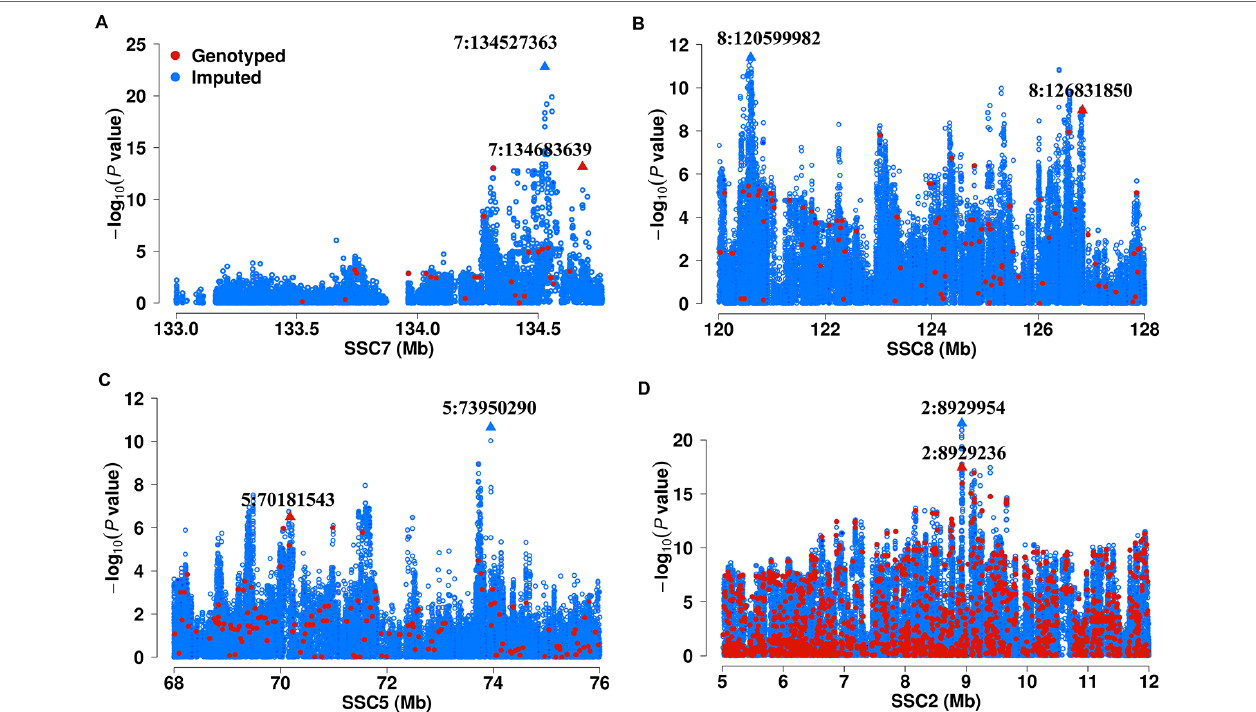
FIGURe 1 | Comparison of association strength between imputed and chip SNPs. (A) region for C20:1n-9 on SSC7 in F 2 population; (B) region for C18:1n-9/ C16:1n-7 on SSC8 in F 2 population. (C) region for C20:0/C18:0 on SSC5 in Sutai population. (D) region for C20:3n-6/C18:2n-6 on SSC2 in Erhualian population. Imputed and chip SNPs were denoted in blue and red color, respectively. The lead SNPs are marked by